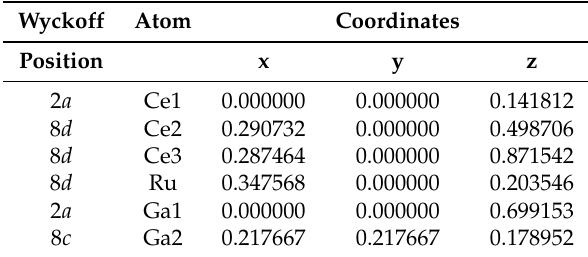
Table 1. Relaxed atomic positions in Ce 9 Ru 4 Ga 5 . Calculations were performed assuming the experimental lattice parameters a = b = 10.1132 Å and c = 8.1212 Å.